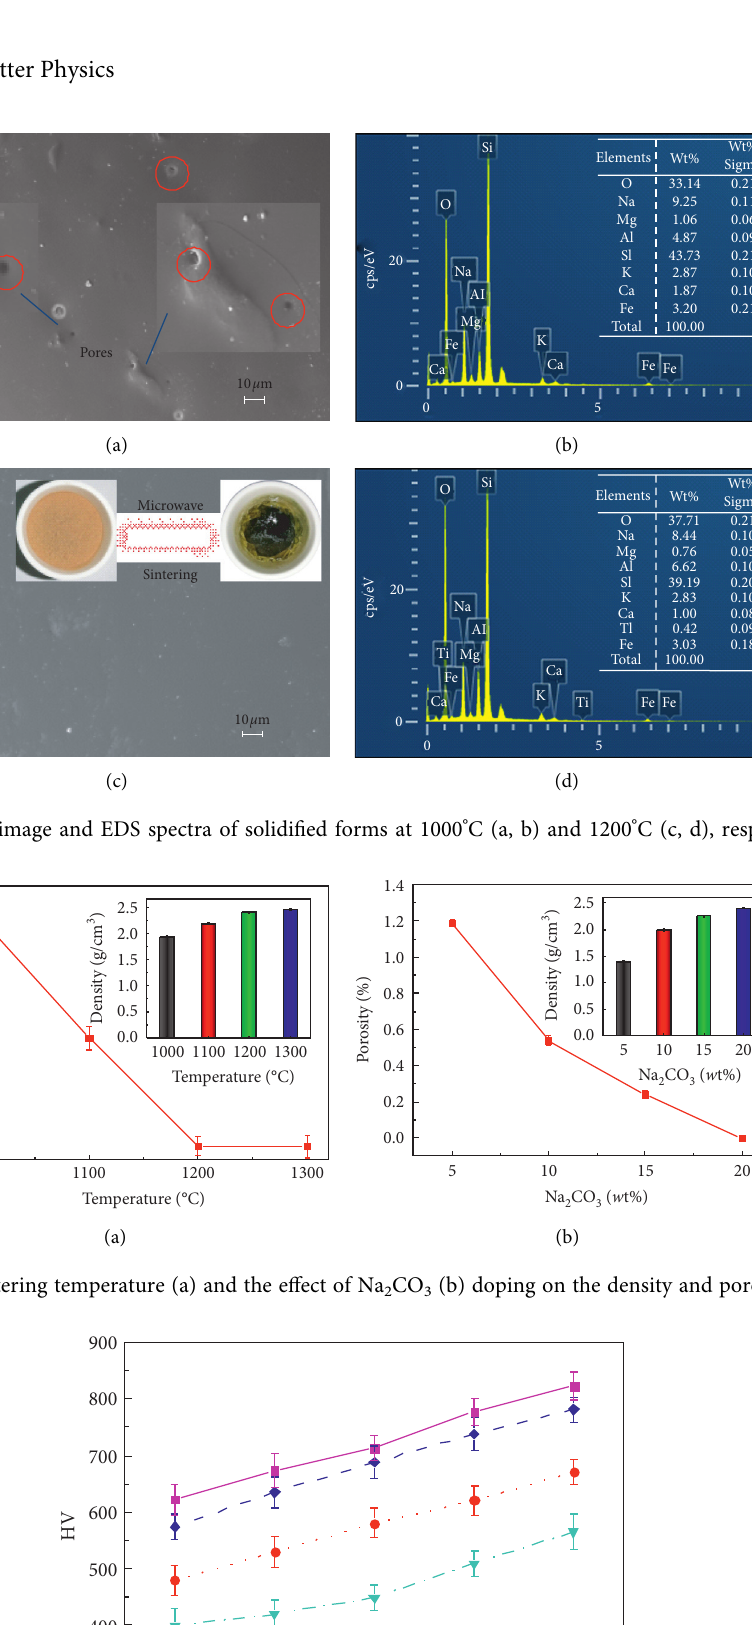
Figure 7: Vickers hardness of different Na 2 CO 3 addition under different